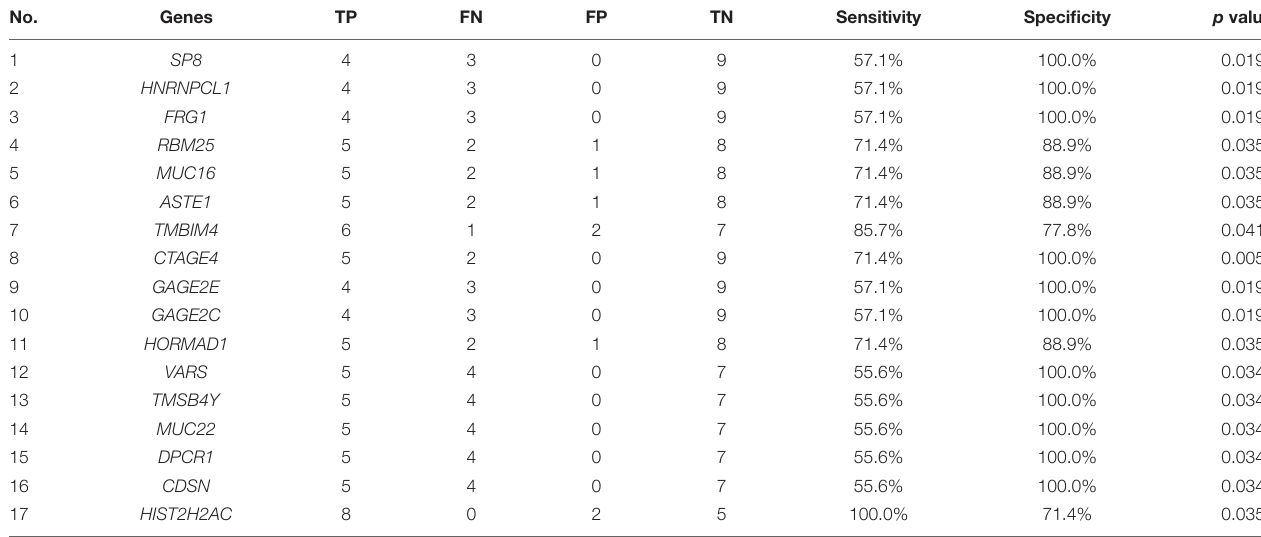
TABLE 2 | The sensitivity and specificity of single gene in assessing dicycloplatin resistance (Nos. 1–11) and dicycloplatin susceptibility (Nos. 12–17). No.